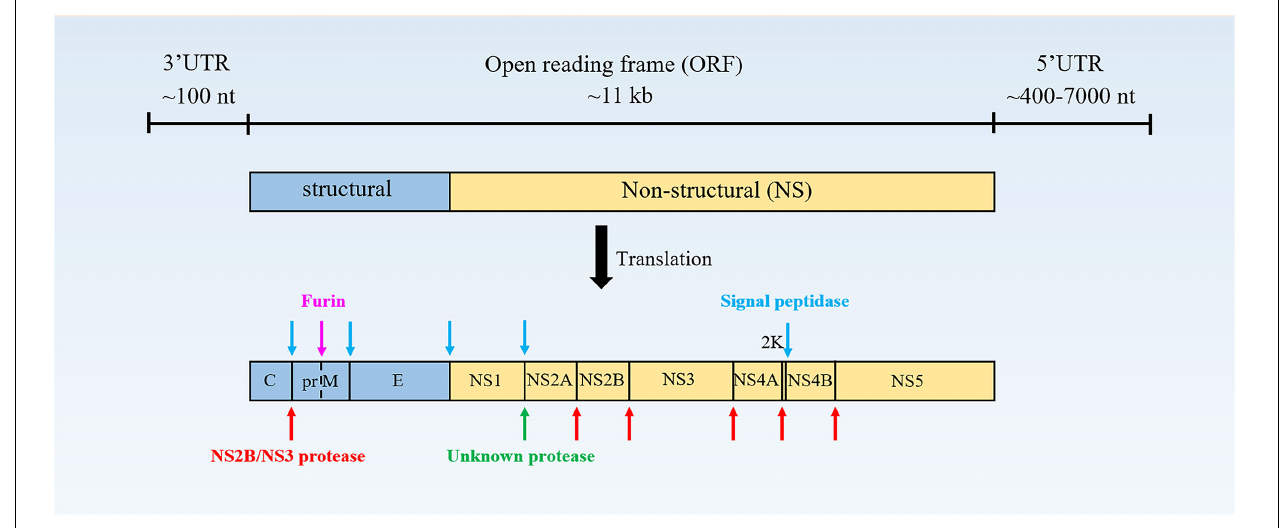
FIGURE 1 | The structure of the flavivirus genome. The protein is cleaved co- and post-translationally to form capsid (C), membrane (M), and envelope (E) structural proteins and non-structural proteins (NS)-1, 2A, 2B, 3, 4A, 4B, and 5 (Vicenzi et al.,